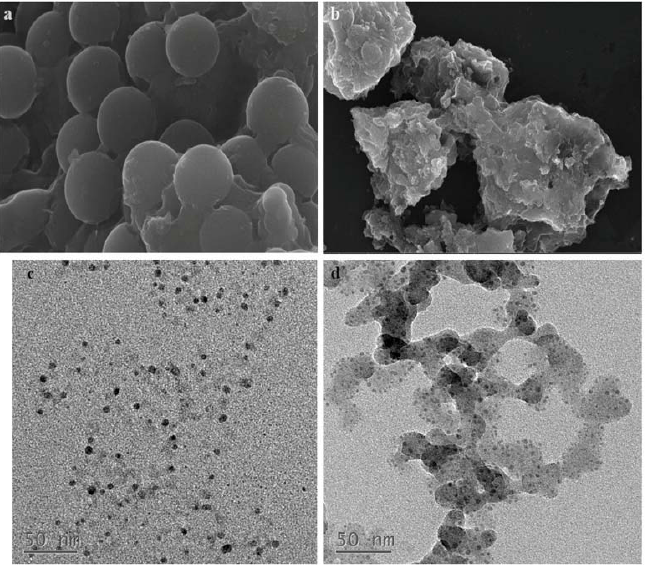
Figure 2. SEM images of SMGO ( a ), SMGO-PPAR- γ ( b ), TEM images of SMGO ( c ), and SMGO- PPAR- γ ( d